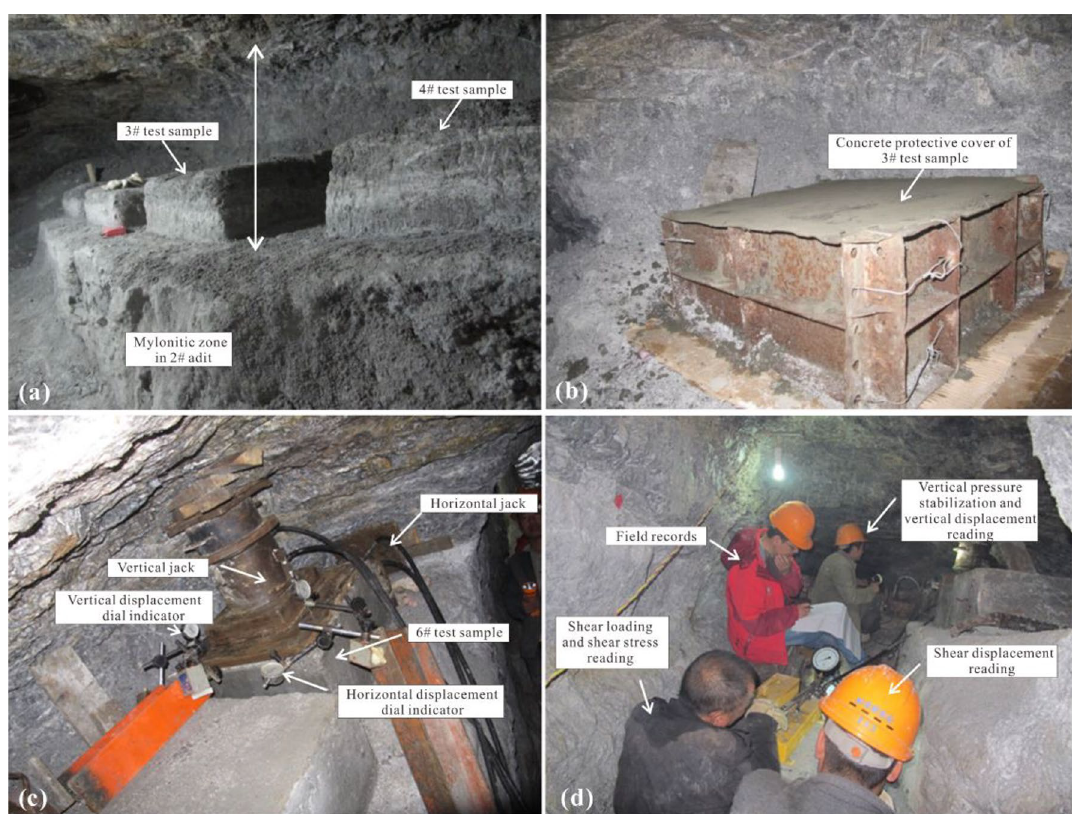
Figure 5. Process of in-situ shear test ( a ) Field pictures of 3# and 4# test samples, and mylonitic zone in adit; ( b ) Concrete protective cover of 3# test sample; ( c ) Device of in-situ shear test and 6# test sample; ( d ) Field record of in-situ shear